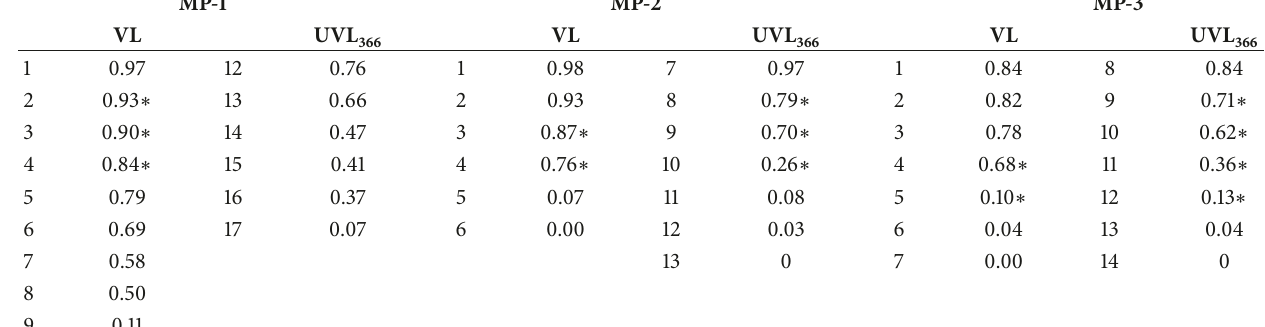
Table 2: Retention factor (R F ) values of spots observed in the 1D-TLC plates, developed using the indicated mobile